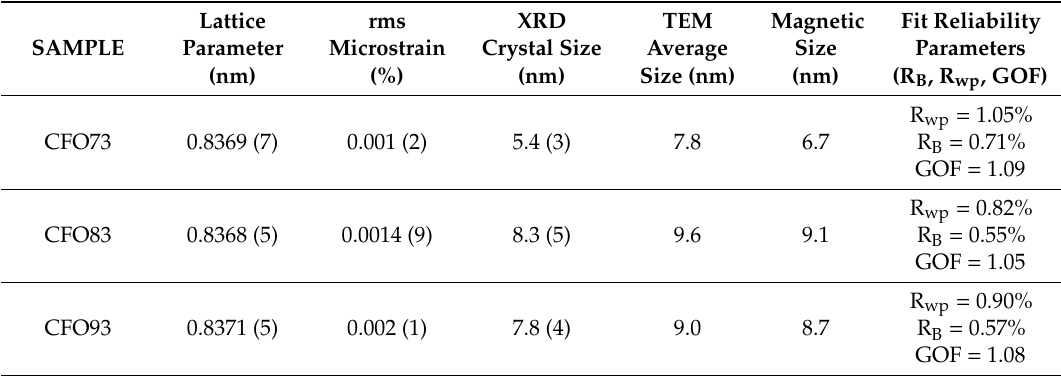
Table 2. Parameters extracted from Rietveld refinements of XRD data and TEM and magnetic size of the nanoparticles